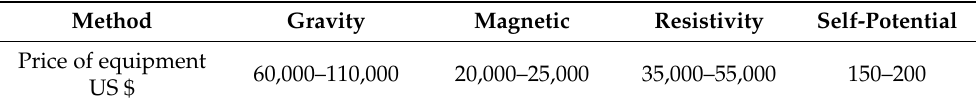
Table 1. Average prices for geophysical potential field equipment (on the basis of author’s personal contacts with the various manufacturers of geophysical equipment (January